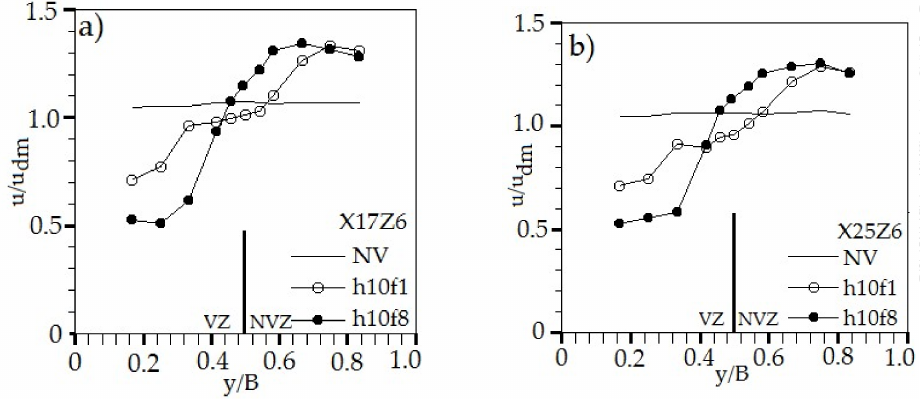
Figure 12. Non-dimensional streamwise velocity distributions along the spanwise direction at z / h v = 1.25 for h v = 0.1 m and different SVFs; ( a ) X17; ( b ) X25. Meftah et al. [32] studied on flow patterns in partly obstructed channel. They used a rigid emergent vegetation layer to illustrate the obstruction in the channel. Density of the vegetated area was given as n = 400 cylinders/m 2 in their studies. They performed mid-depth velocity measurements using ADV in the experiments. They stated that the flow properties depend on contraction ratio (C r ) which is the ratio of the width of the obstructed area to the width of the unobstructed area. The results they obtained in the unobstructed area near the obstructed area and our results in the wake region of vegetation layer (data in Figure 11 where data correspond to the mid-depth of the vegetation layer) were plotted in Figure 13. Here, R1, R2, R3 and R4 correspond to C r = 3.21, C r = 1.05, C r = 0.36 and C r = 0.16, respectively. The contraction ratio was C r = 0.94 in our study. In Figure 13, y’ starts at